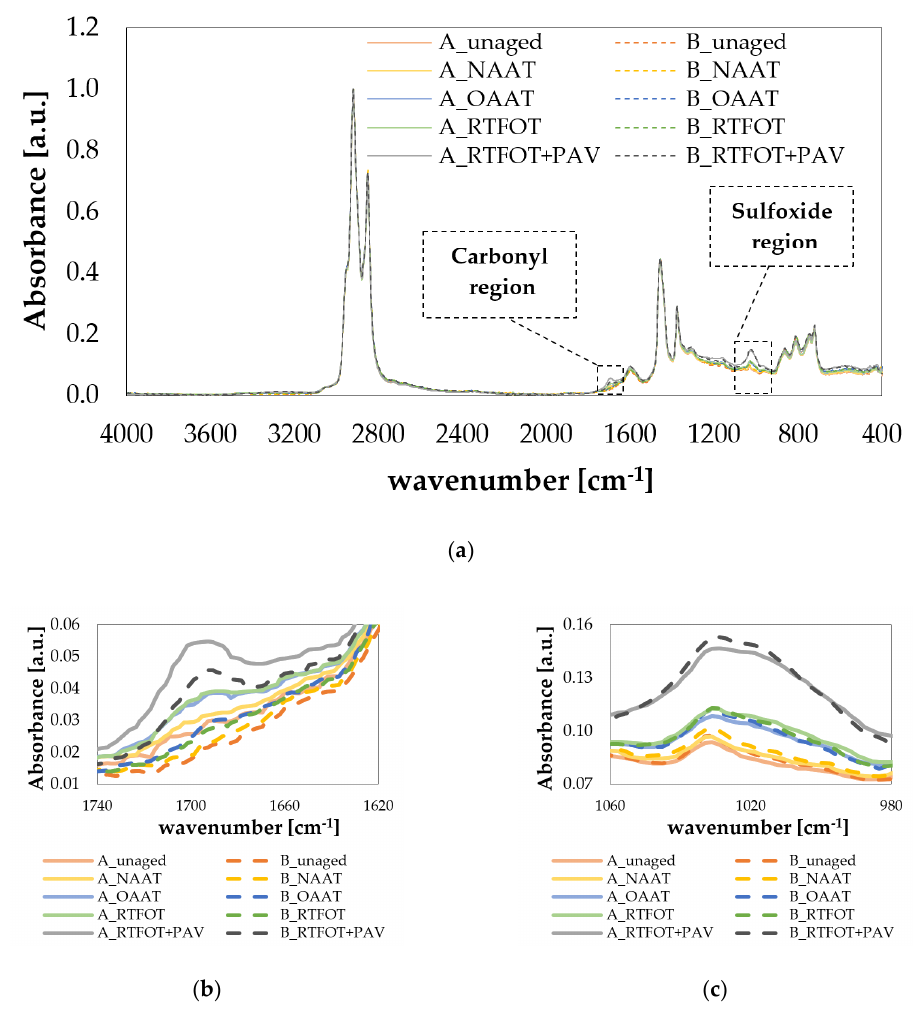
Figure 8. FTIR spectra: ( a ) complete spectra, ( b ) carbonyl region, and ( c ) sulfoxide region.